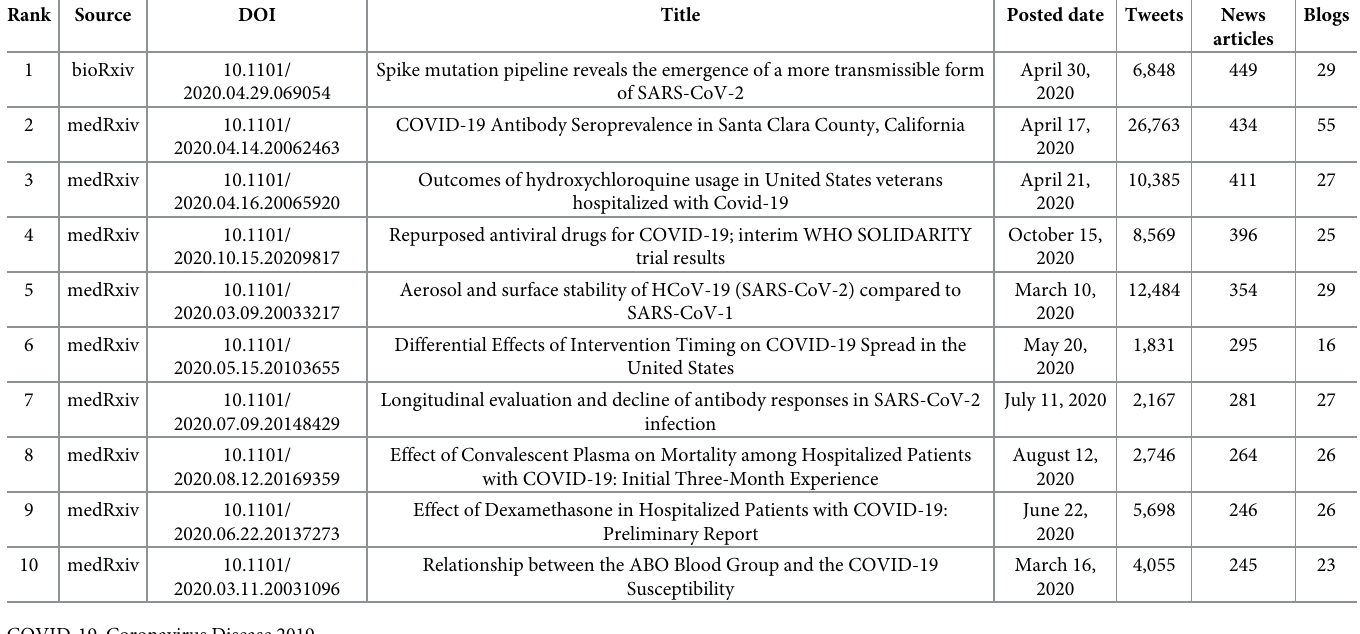
Table 3. Top 10 COVID-19 preprints covered by news organisations.